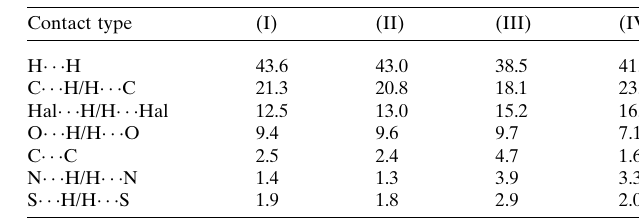
Table 5 Hirshfeld contact interactions